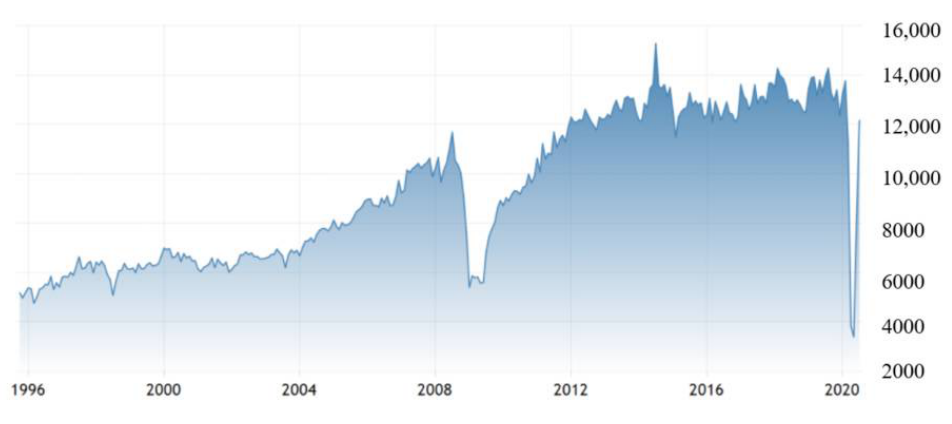
Figure 1. Export of American vehicles from 1996 to 2020 [8].